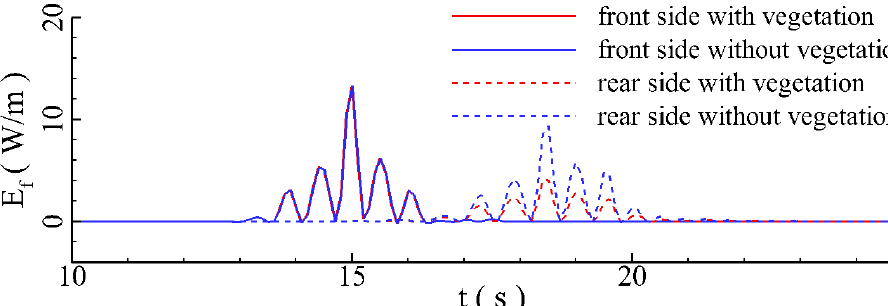
Figure 9. Spatial distribution of the local maximum wave height.